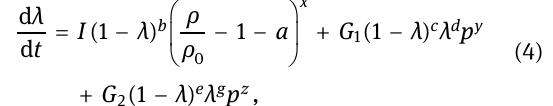
Figure 6: Finite element model of ERA.